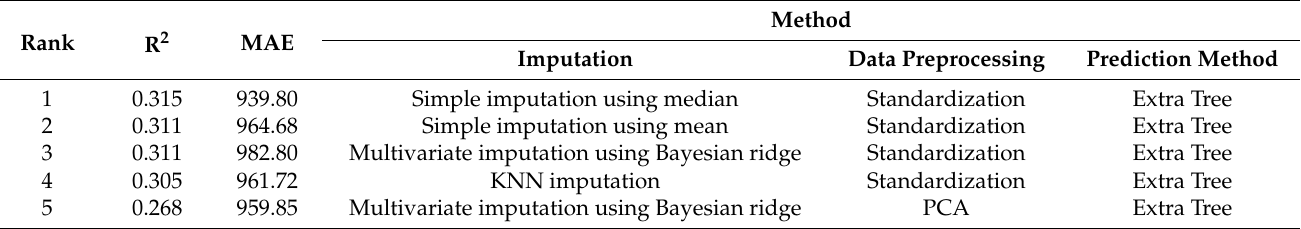
Table 5. Top 5 proposed results based on R 2 and MAE when missing data is not